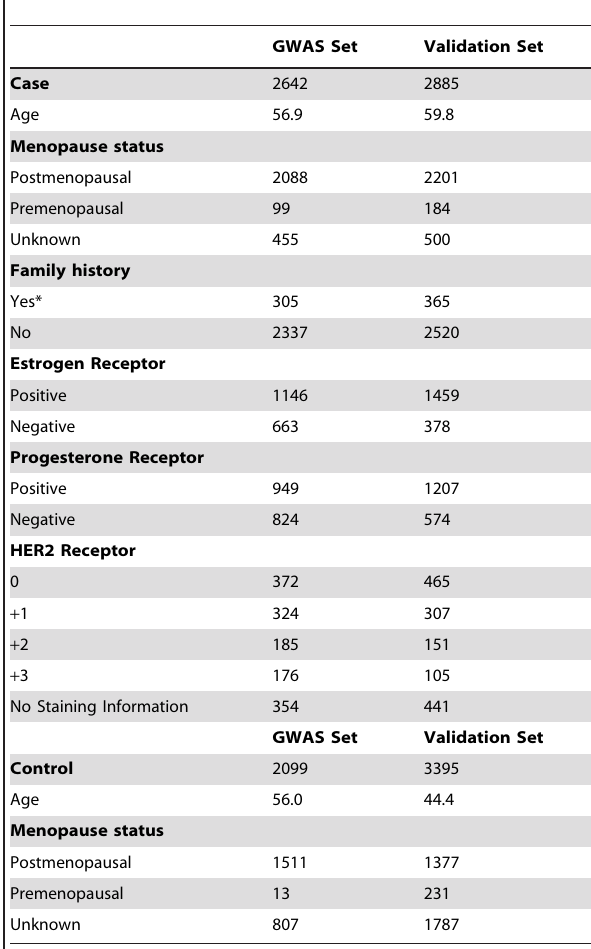
Table 1. Demographic data of patients recruited for this